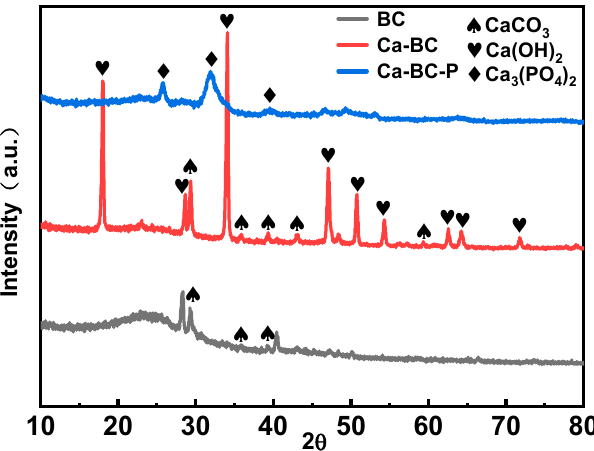
Figure 7. XRD spectra of BC , Ca-BC, and Ca-BC-P materials.